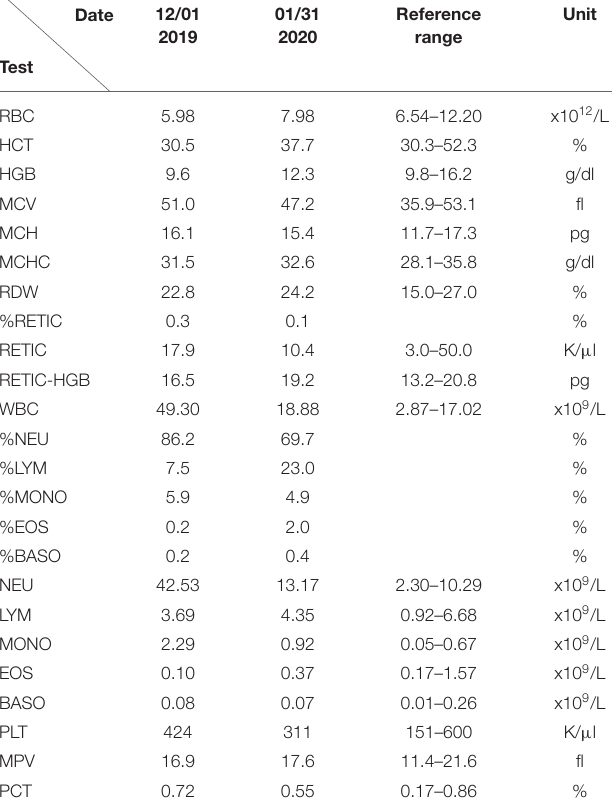
TABLE 2 | Blood hematology